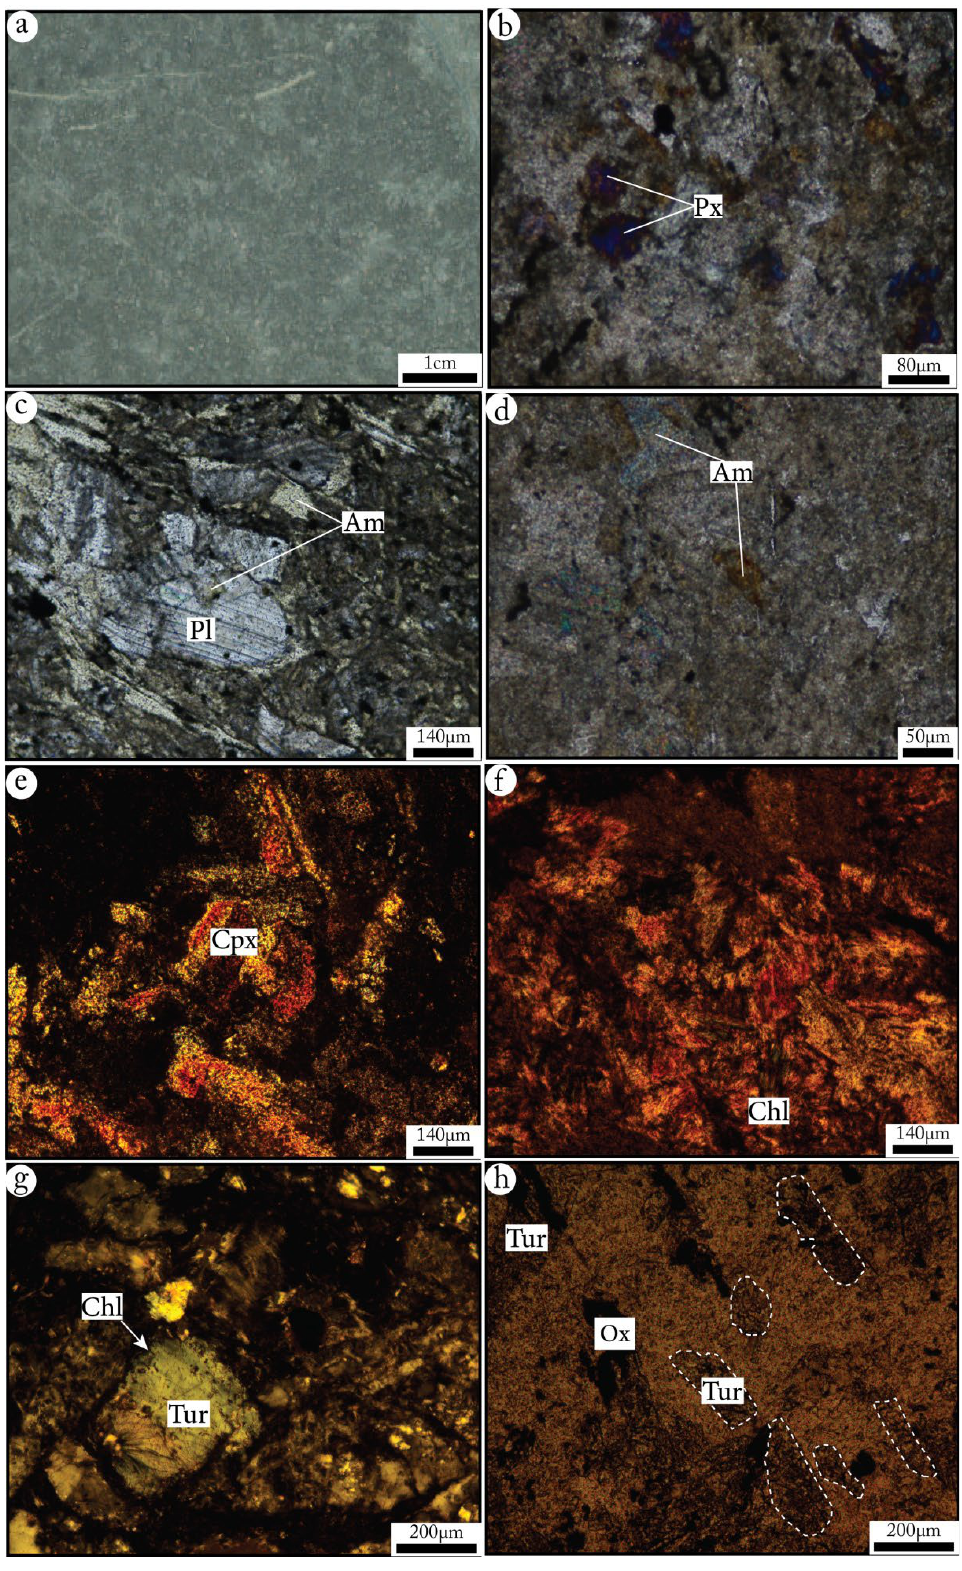
Figure 15. ( a ) Macroscopic view of a dolerite facies. ( b – h ) Microphotographs of dolerites: plagioclases (Pl), amphibolitized (Am) pyroxenes (Px), clinopyroxenes (Cpx), chloritized (Chl), tourmaline (Tur) and oxides (Ox) (transmitted light—crossed nicols).